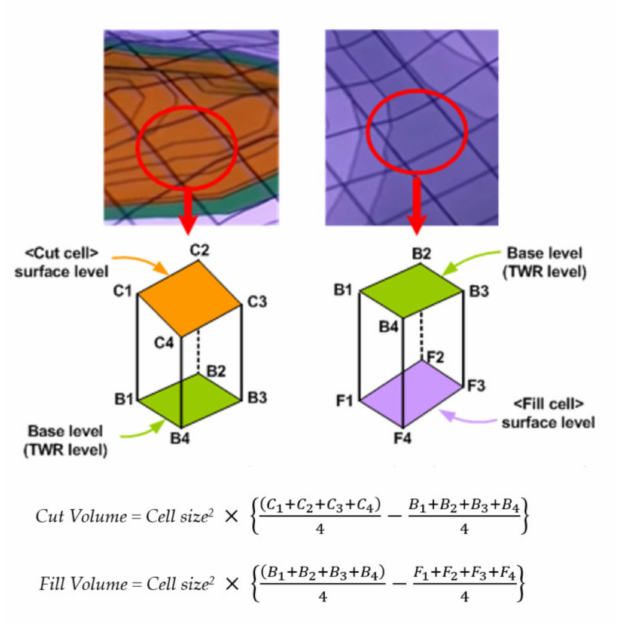
Figure 6. Work volume calculation.